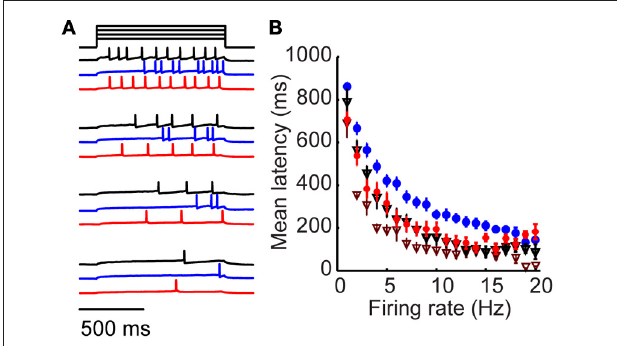
FIGURE 4 | Long-latency activation is an intrinsic property specific to tufted cells. (A) Example mitral (black), tufted (blue) and tufted cell + 4-AP responses to four amplitudes of injected current. (B) Firing rate/latency relationship in response to somatic current injection across the population of mitral cells (black triangles) and tufted cells (blue). Red circles denote tufted cells in the presence of 20 μ M 4-AP; maroon triangles denote mitral cells in the presence of 20 μ M 4-AP. Bars indicate